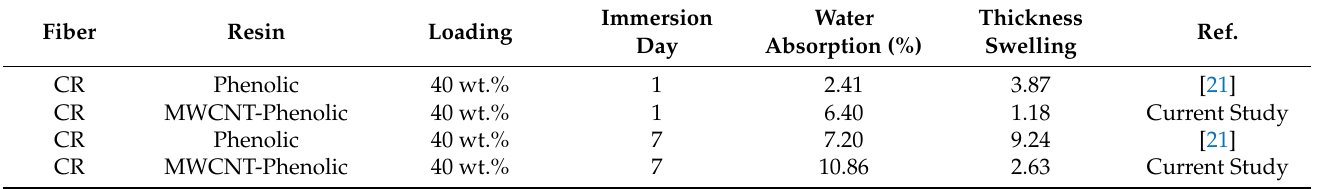
Table 4. Comparison of CR fiber-reinforced MWCNT-Phenolic composites with CR fiber-reinforced phenolic composites. Fiber